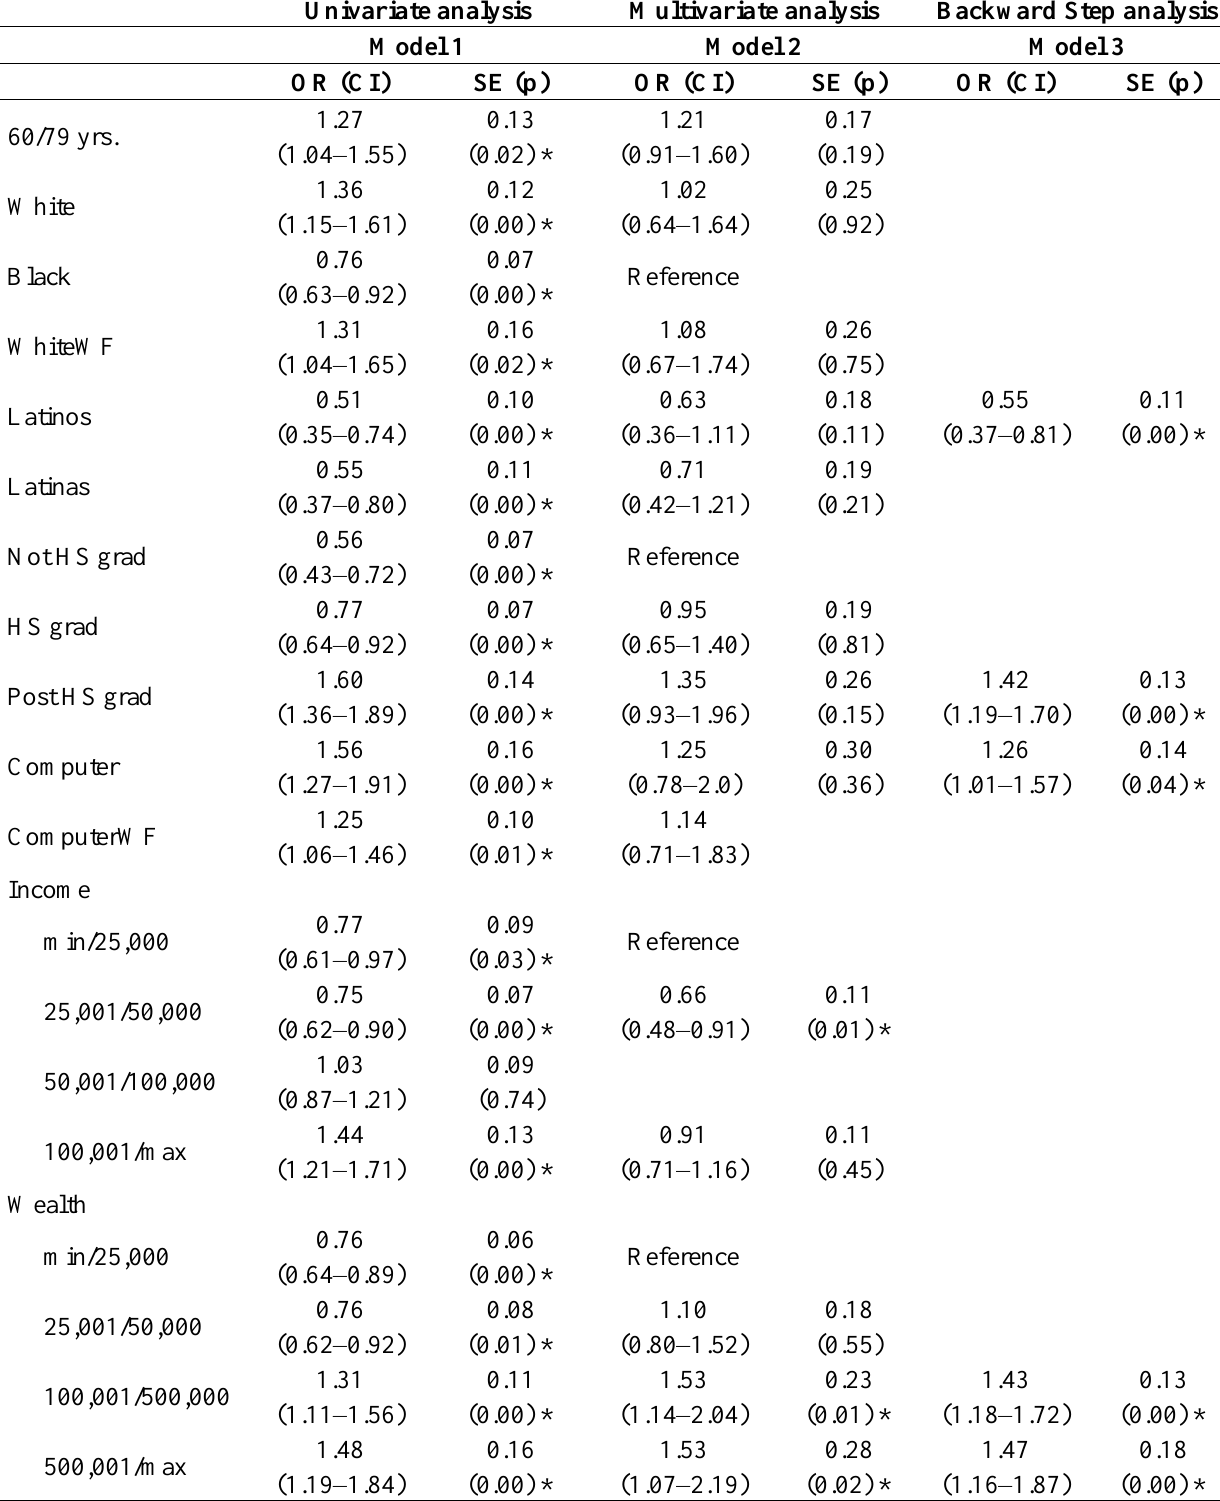
Table 5. Logistic models predicting charitable giving to needy